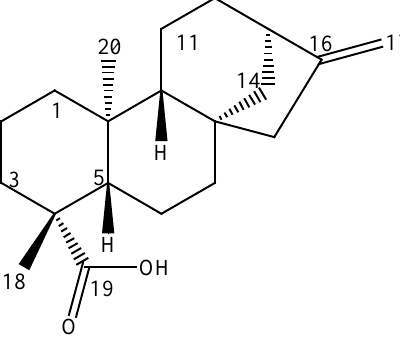
Figure 5. Chemical structure of kaurenoic acid ( 1 ).